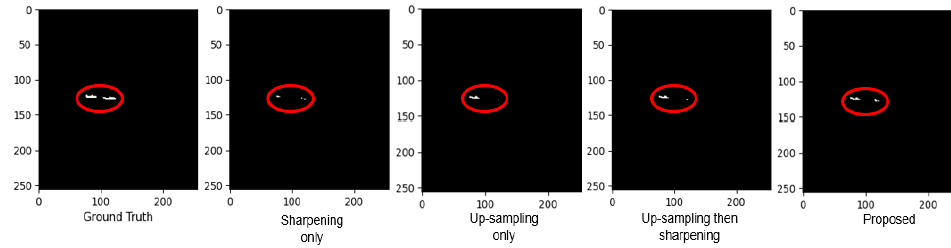
Figure 15. Ablation study.